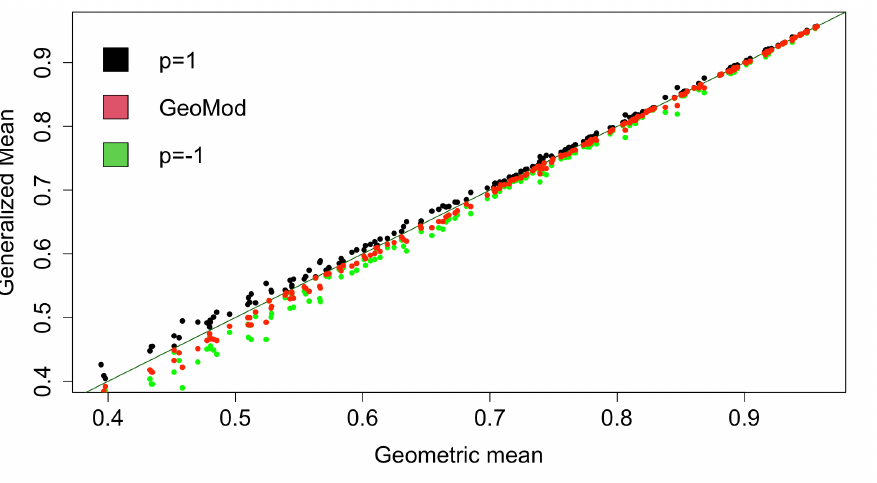
Figure 6. Scatter plot of the harmonic mean version (in green), the arithmetic mean version (in black) of the HDI and the pHDI values (in red) vs. the HDI